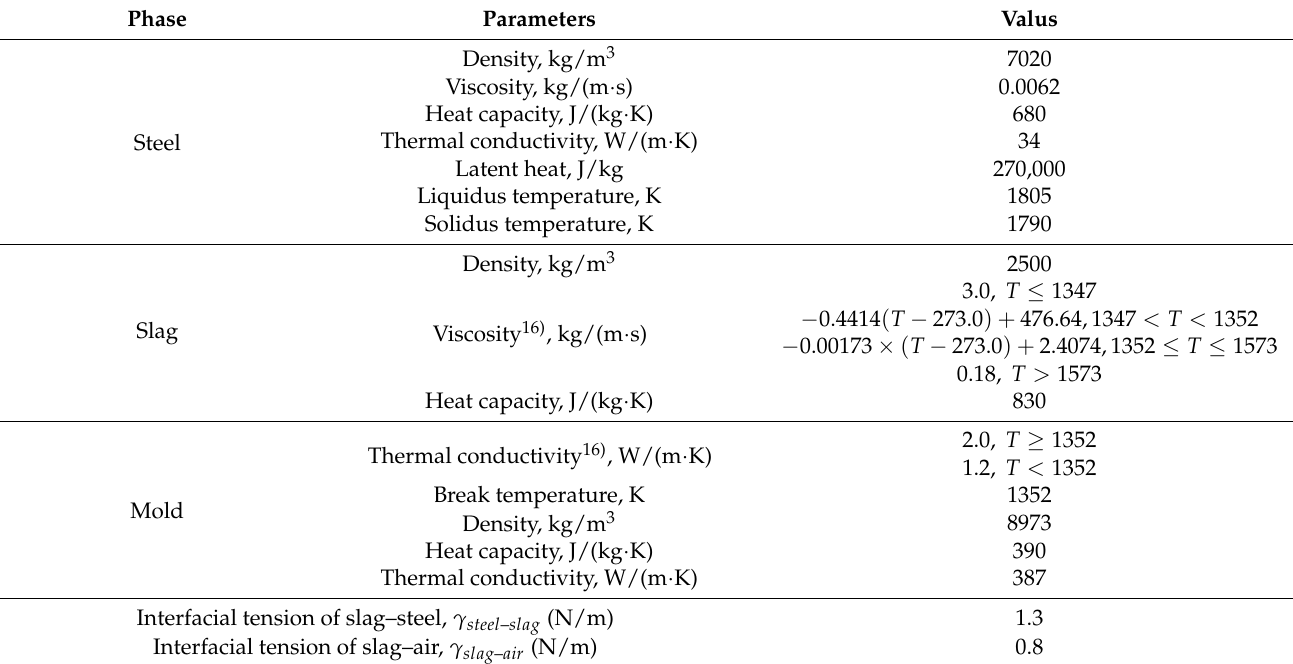
Table 2. Material